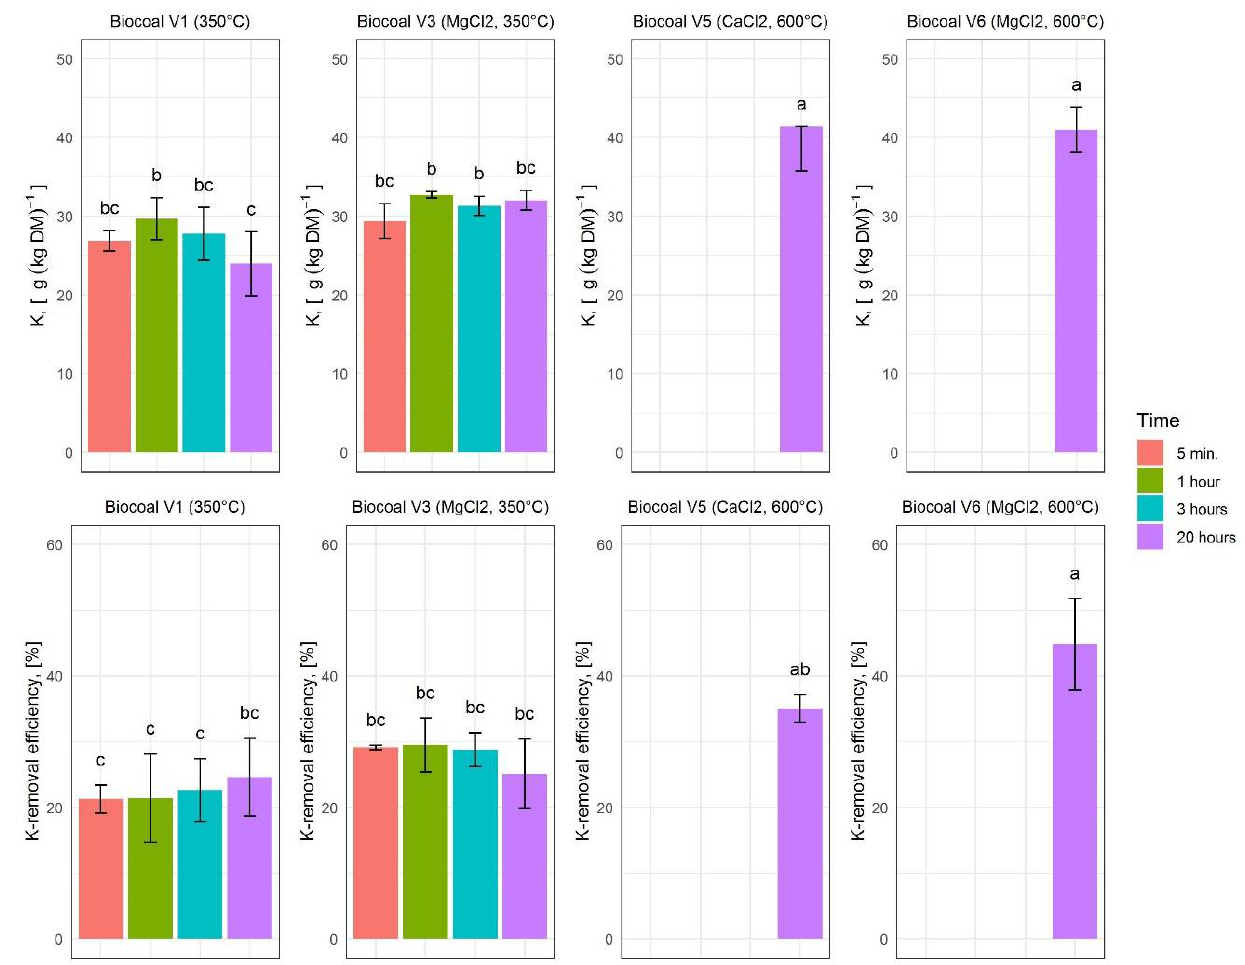
Figure 8. Potassium (K) concentration and K-removal efficiency for the different variants of added biocoal. The upper diagrams show the K concentration. The lower diagrams show the removal efficiency. Histograms are charted based on the mean values; error bars indicate the variability between the three replications. Lower case letters indicate significant differences according to Tukey test.